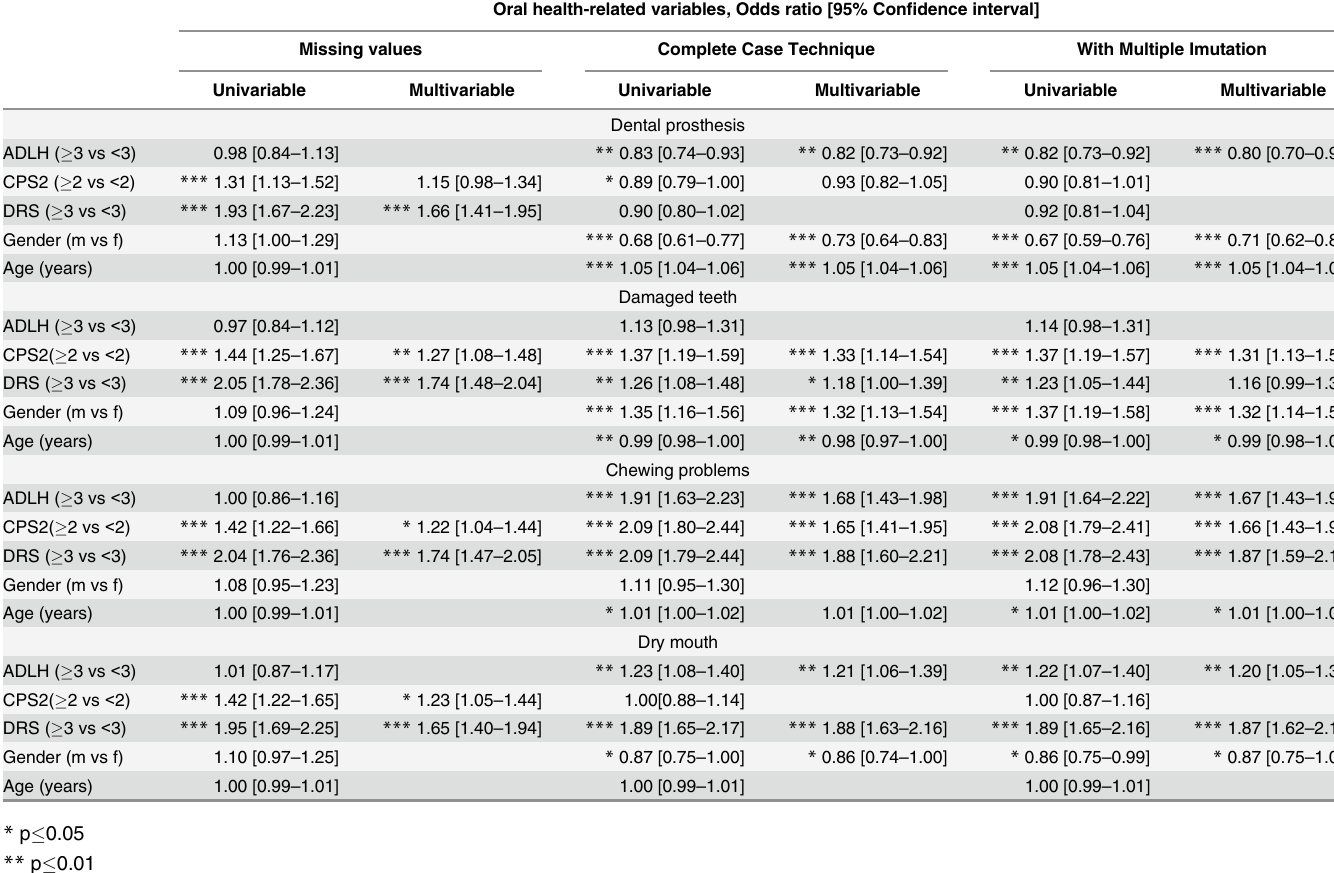
Table 2. Oral health-related variables and corresponding missing values: associations with ADLH, CPS2 and DRS. Oral health-related variables, Odds ratio [95% Con fi dence interval] Missing